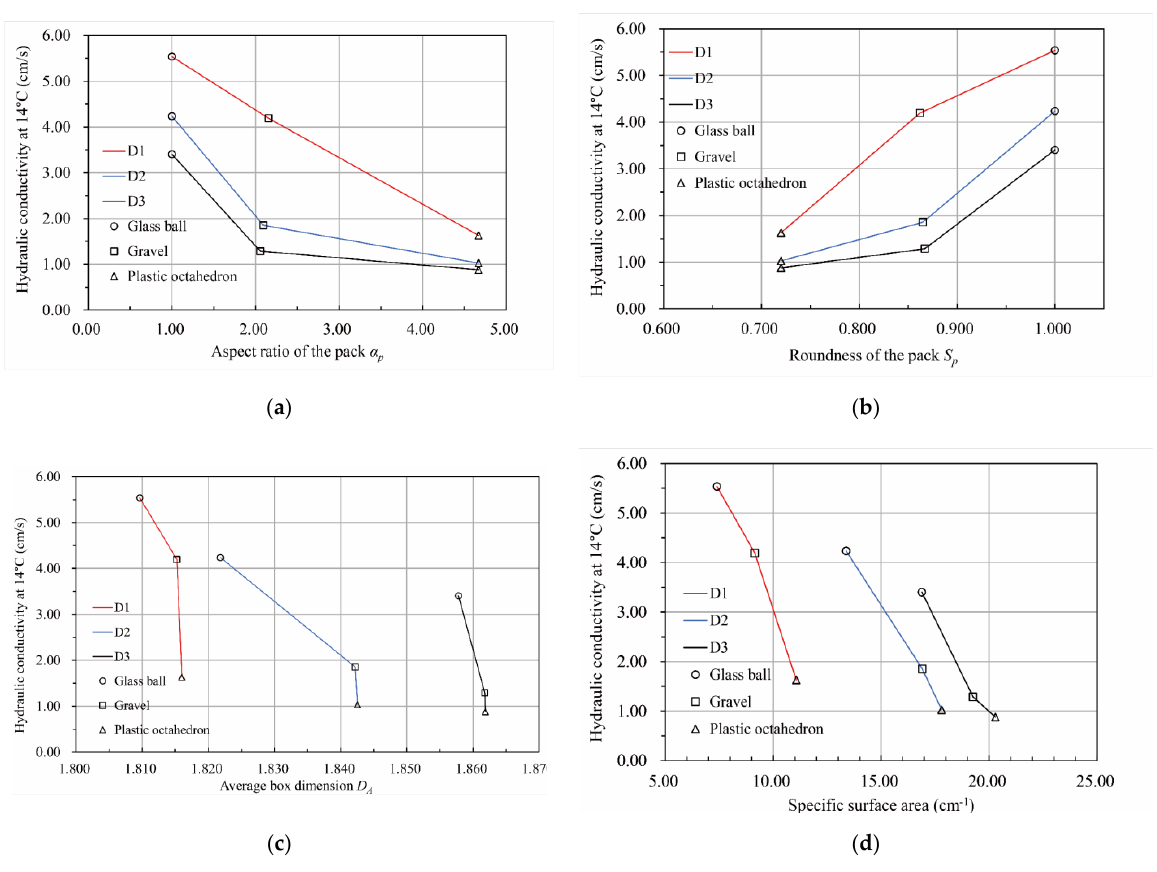
Figure 18. The relationship between the hydraulic conductivity and the pore characteristics of packs. ( a ) The relationship between the aspect ratio of the pack and the hydraulic conductivity. ( b ) The relationship between the roundness of the pack and the hydraulic conductivity. ( c ) The relationship between the average box dimension of the pore – particle interface and the hydraulic conductivity. ( d ) The relationship between the specific surface area of the pore network and the hydraulic conductivity.